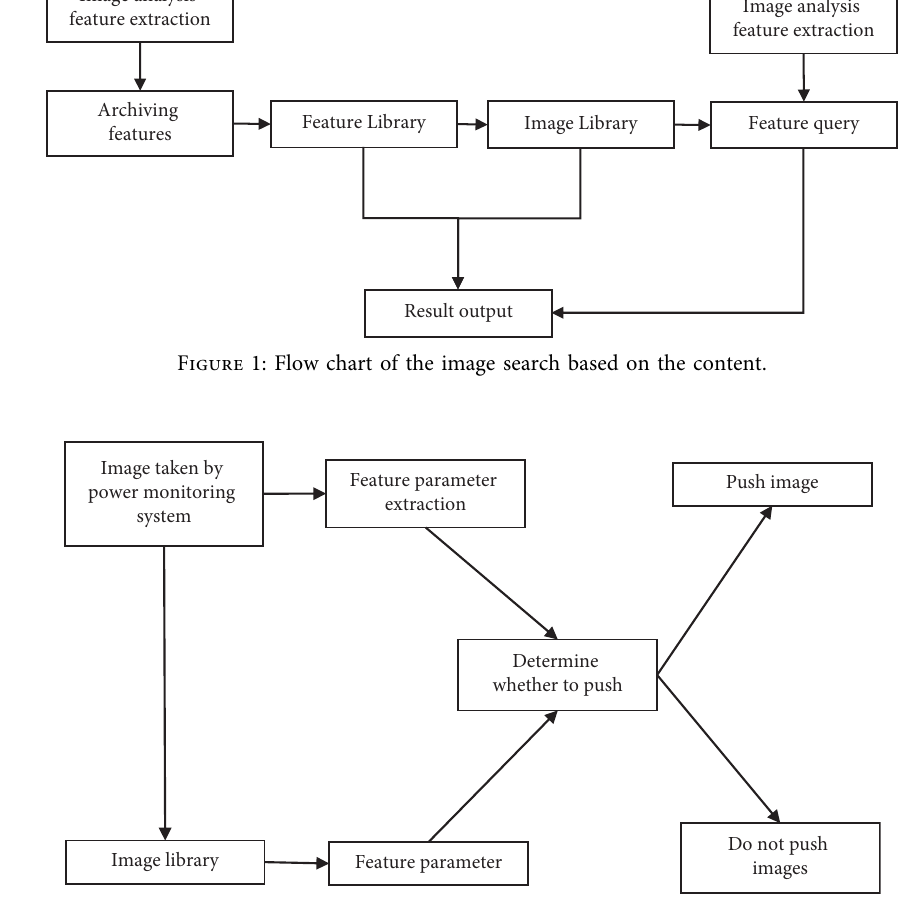
Figure 2: Work flow chart of the intelligent analysis of the